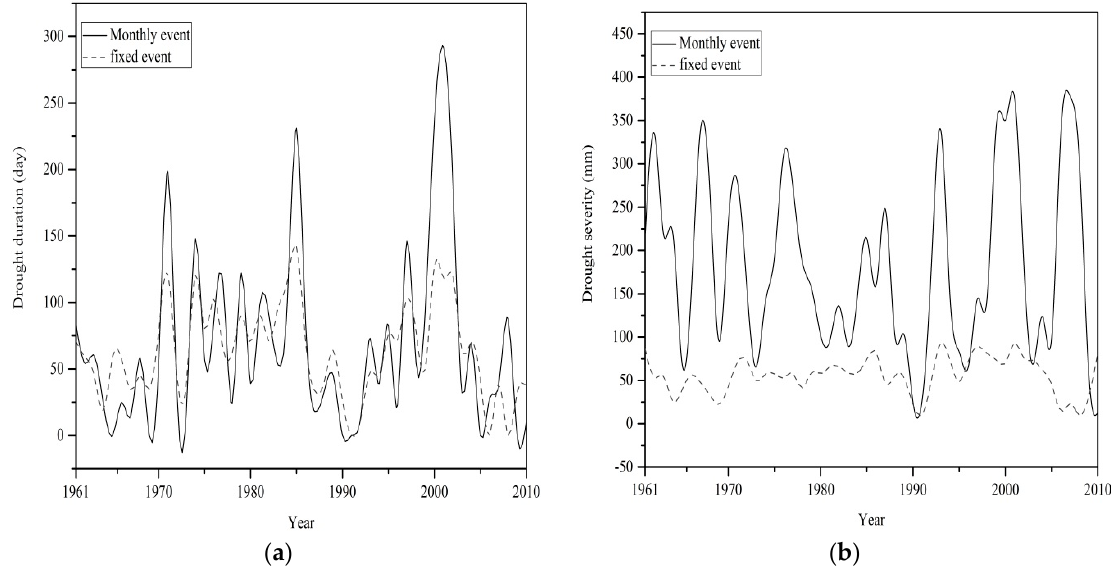
Figure 24. Annual duration and average severities of Zone II. ( a ) Drought duration ( b ) Drought Severities.